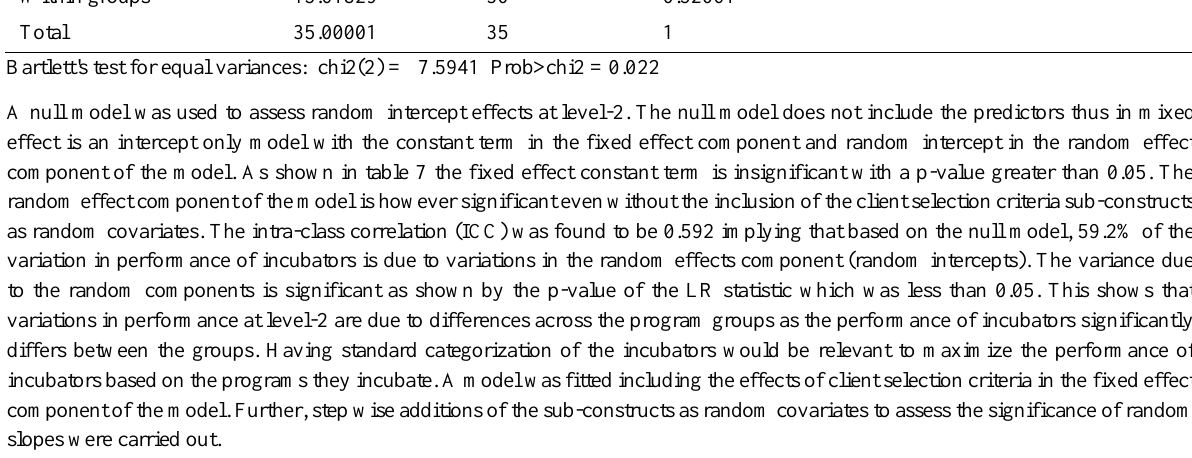
Table 7 : Null Model of Incubator Centre